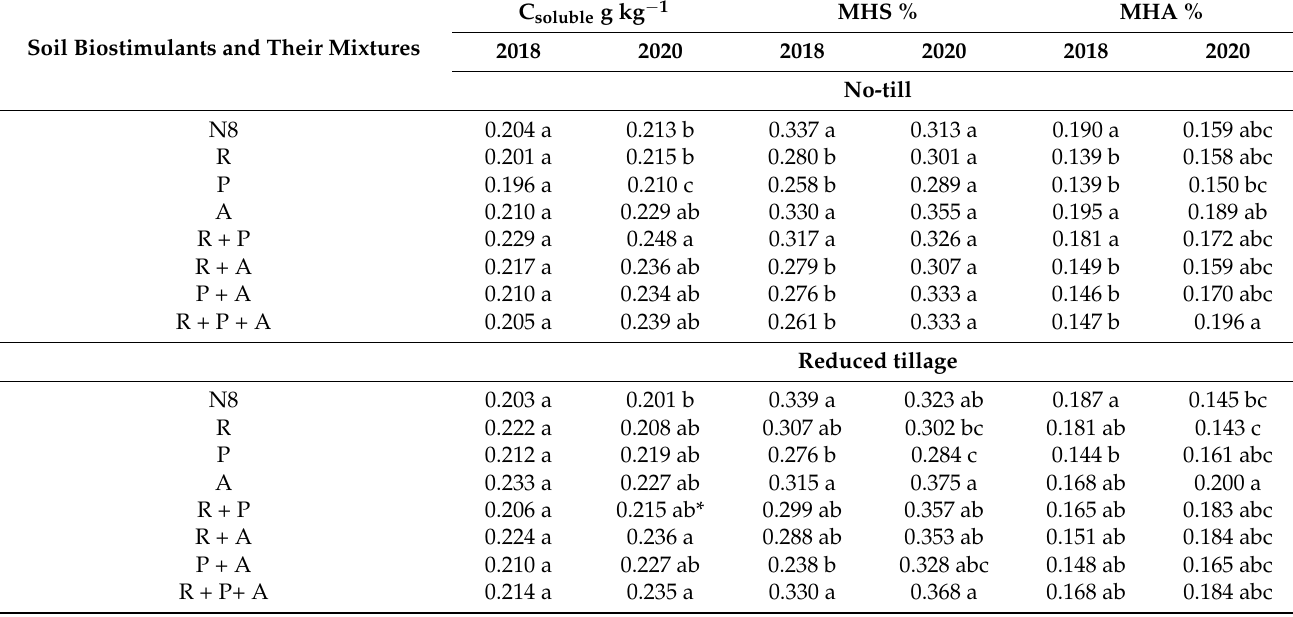
Table 5. The influence of biostimulants and their mixtures on the soil content of water-soluble carbon (g kg − 1 ), mobile humic substances, and mobile humic acids